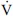
CPET of a PH patient who had a late-developing EIS at the end of exercise.The CPET course was comprised of three minutes of rest, three minutes of unloaded cycling followed by progressively increasing WR of 10 watts/min for the patient and eventually four minutes of recovery. Just before the end of exercise, the PH patient developed a late-developing EIS marked with the gas exchange findings of an abrupt increase in V˙E/V˙O2 (EqO2), V˙E/V˙CO2 (EqCO2), PETO2 and RER, accompanying with a simultaneous decrease in PETCO2 and SpO2, then these changes suddenly returned toward their pre-shunt values when exercise stopped.